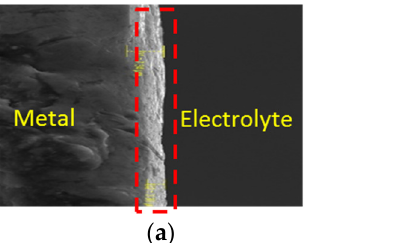
Figure 3. E ff ect of chloride ion concentration on open circuit voltage (OCV). Figure 3. Effect of chloride ion concentration on open circuit voltage (OCV).